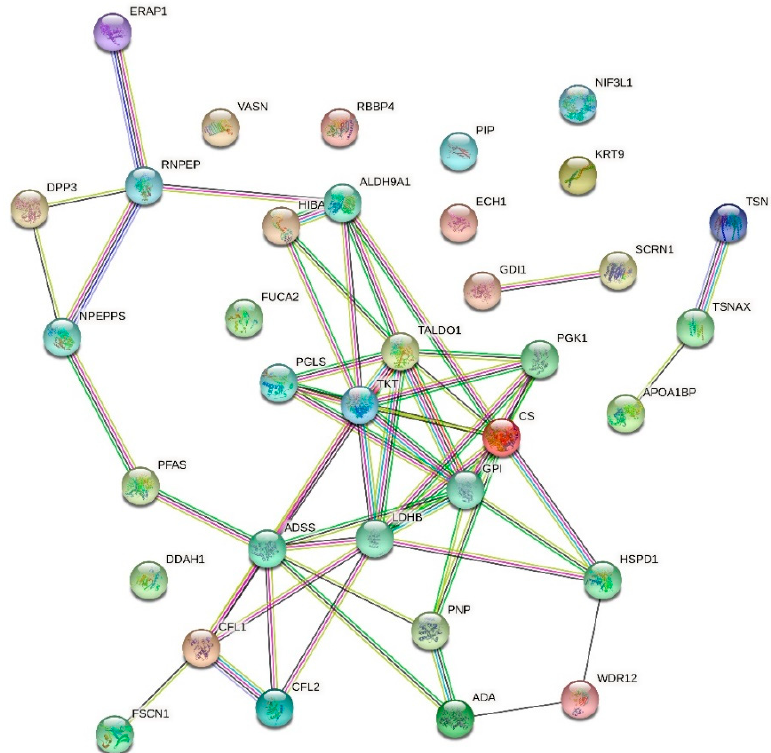
Figure 10. Network of up-regulated proteins in the HMEC-1 secretome. The network, obtained with the software STRING, includes the secreted proteins that were found to be up-regulated in cells treated with 5 g/L urea for 72 h compared to control cells.